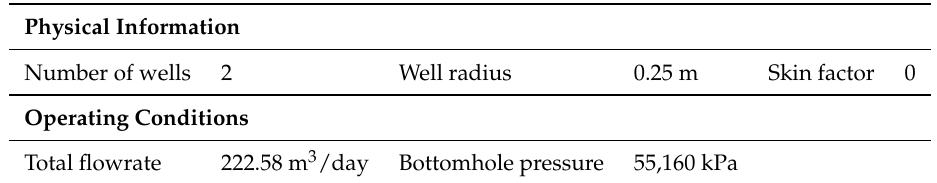
Table 2. Wells’ physical and operating conditions (reproduced with permission from Druetta [28], Elsevier,